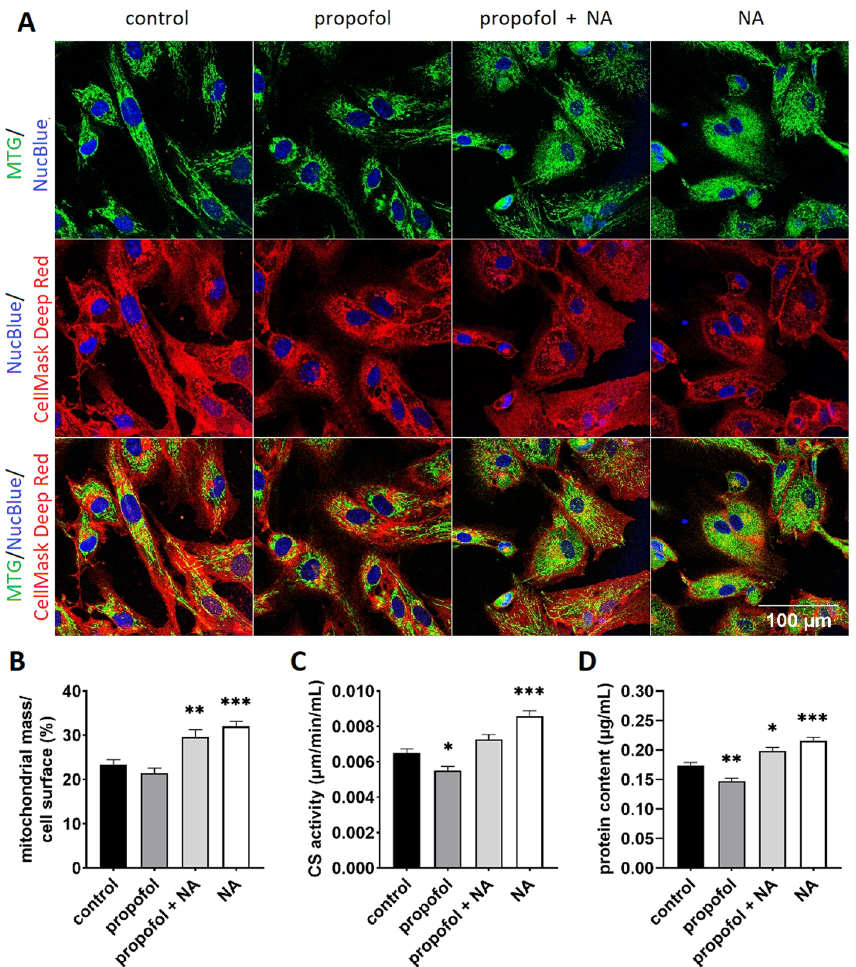
Fig. 2 A and B Analysis of mitochondrial mass by confocal imaging of exposed myoblasts. A Representative confocal images of each channel after dual staining with Mitotracker Green ™ FM (accumulating in mitochondria) and CellMask ™ Deep Red (binding into the cell membrane). Additionally, all cells were stained with nuclear blue-fluorescent probe NucBlue. Experiments were performed at least at 50 cells per each condition from 3 independent measurements ( cells established from 3 individual subjects). = B Mitochondrial mass calculated as a fraction (%) of a cell surface area in 2D cross-sectional images. Mitochondrial mass (mitochondrial footprint) was analysed as a sum of positive pixels (binary image) per cell representing mitochondrial area using ImageJ ™ tool “MINA”. C Activity of CS enzyme measured spectrophotometrically. D Total protein content from frozen cell pellets was determined using Bradford assay as described elsewhere [53]. For both CS activity and protein content measurement, experiments were performed in n 7 replicates in tri- or tetraplicates. Error bars indicate standard error of the mean. * p < 0.05, = ** p < 0.01, *** p < 0.001 vs. control group. CS citrate synthase, MTG MitoTracker Green ™ FM, NA